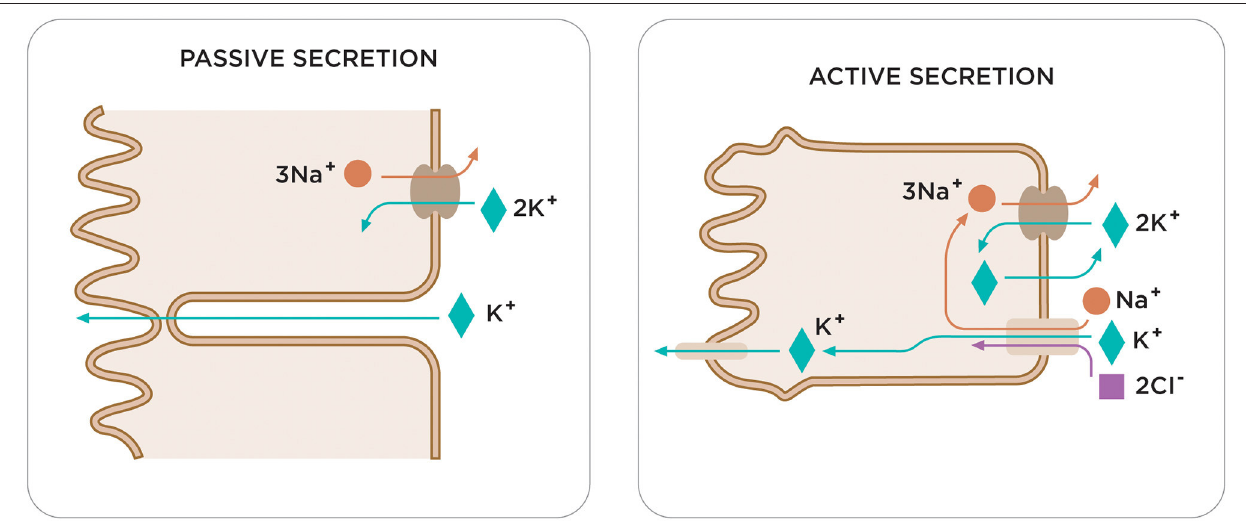
FIGURE 2 | Two compensatory mechanisms in the colon respond to elevated serum potassium levels in patients with CKD. Current studies highlight the existence of a feed-forward control in the regulation of potassium homeostasis, capable of causing rapid changes in renal potassium excretion. Among the different elements of this feed-forward control, the colon plays a fundamental role in the regulation of potassium. It is worth noting the different transport capacity of the potassium in the various segments of the colon or the different expression or activity of potassium channels on the membrane apical of the colon (BK channels). Although the role of the colon in excretion of potassium is not well-known yet, recent studies have found that in CKD the colon is responsible for a considerable increase in potassium removal, which is attributed to an increase in activity of the BK channels. There are two compensatory mechanisms in the colon in response to elevated serum potassium levels in patients with CKD: passive and active secretion.